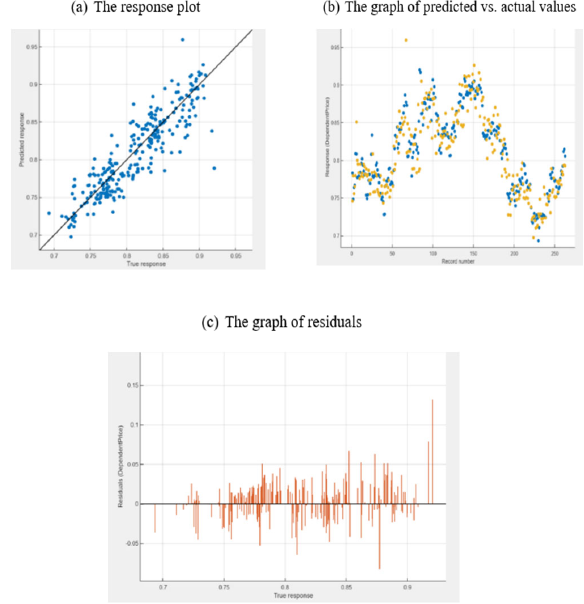
Fig. 10. Performance Graphs of Prediction Made with Artificial Neural Networks